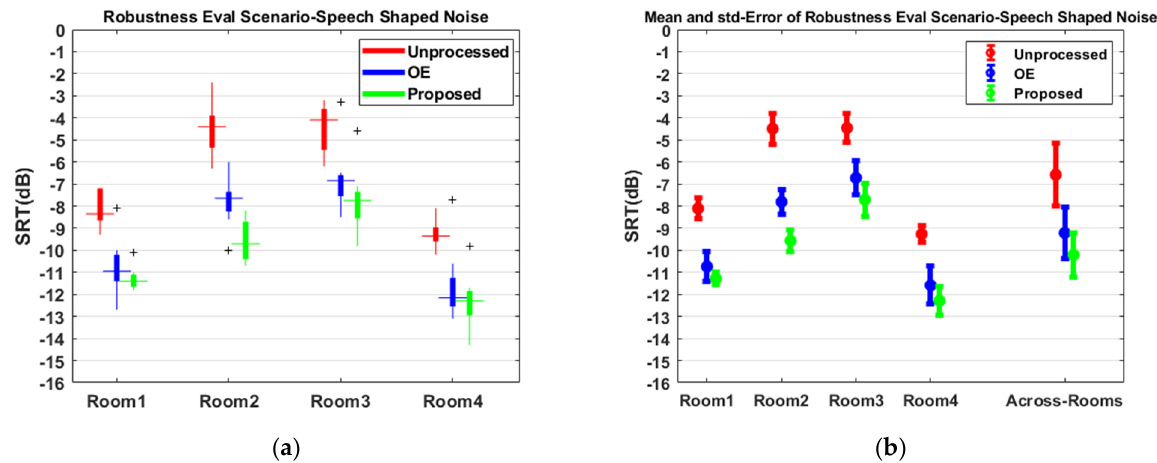
Figure 10. ( a ) Boxplots of speech reception thresholds at SRT 50 for 8 subjects to evaluate the robustness of preprocessing methods, measured in the presence of SSN are illustrated. The unprocessed and the preprocessed signals for the robustness evaluation scenarios using the OE and proposed method are compared; ( b ) The mean-SRT 50 and the standard errors for the same data are plotted.